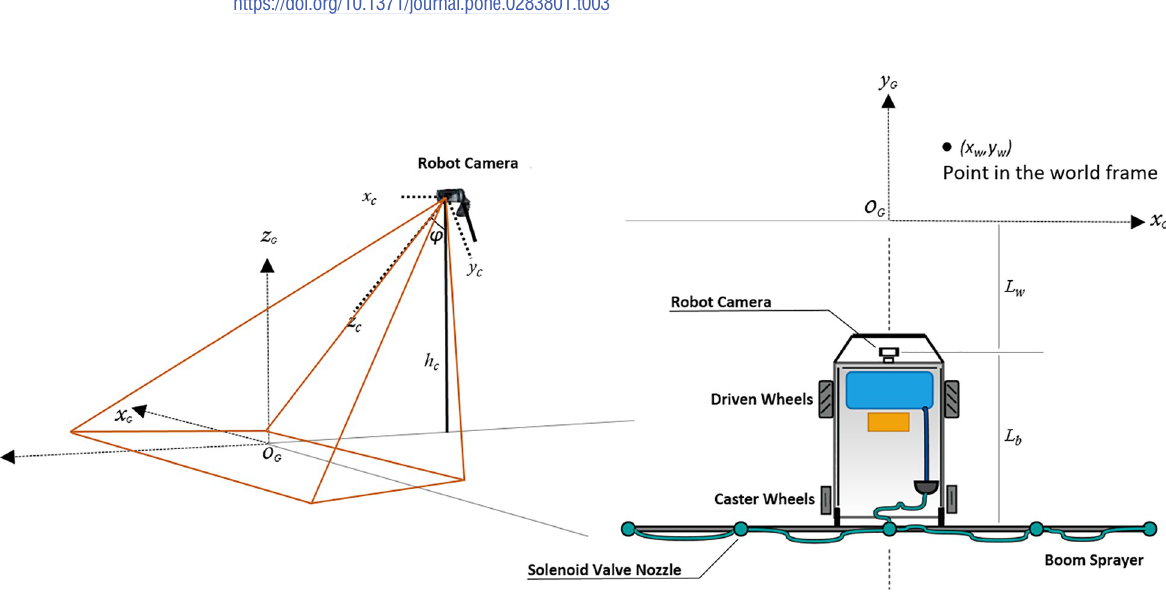
Fig 3. Object coordinates transformation from camera frame to world